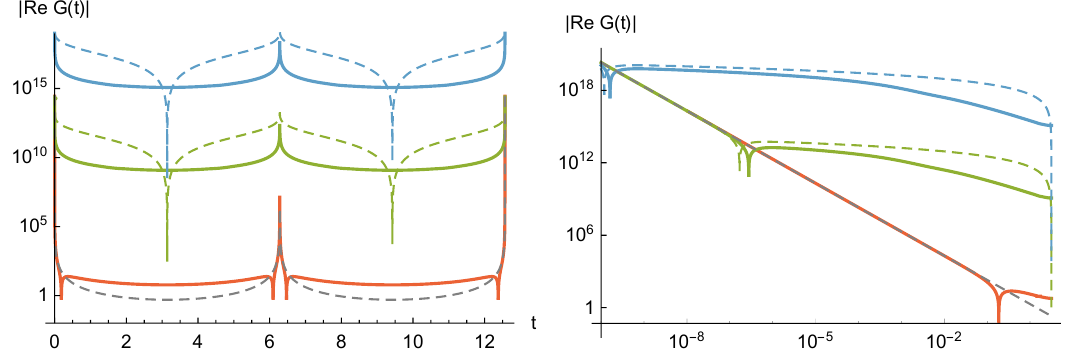
Figure 2 . Vector model, d=3. j G ( t ) j for (cid:12)=(cid:12) c = 50 (red), (cid:12)=(cid:12) c = 10 (cid:0) 3 (green) and (cid:12)=(cid:12) c = 10 (cid:0) 6 (blue), with t a (cid:24) 3 (cid:1) 10 (cid:0) 3 in both high temperature cases. The gray dashed line depicts the vacuum correlator, while the colored dashed lines correspond to an unconstrained theory at the respective temperature, displayed only for (cid:12) < (cid:12) c . The logarithmic plot on the left illustrates the periodicity of the correlators, as well as the renormalized low temperature behavior (shifted red curve) for t > t a . More of the features can be extracted from the log-log plot on the right.